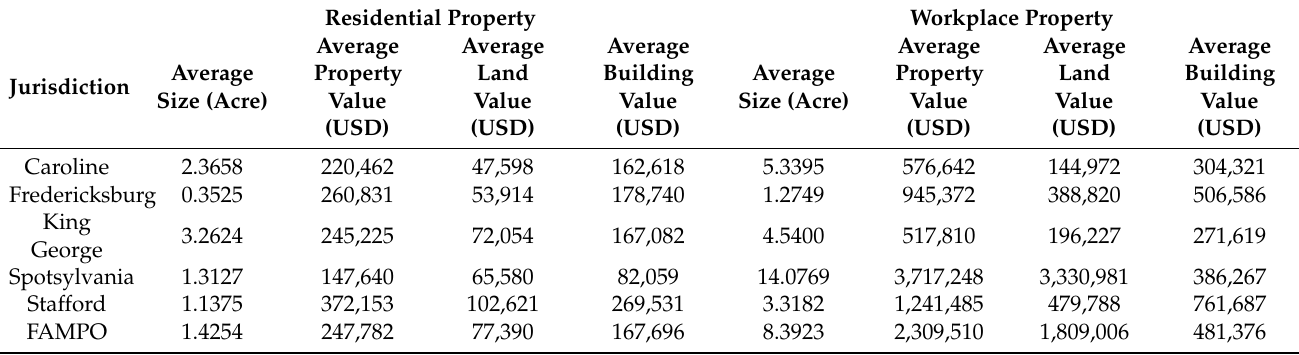
Table 3. Average Parcel Data in